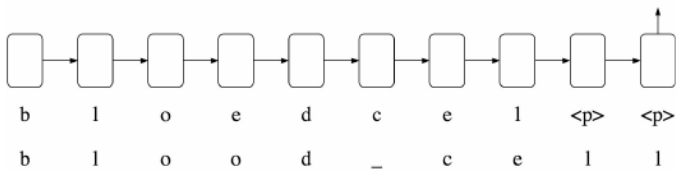
Figure 10. Character-level representation in an LSTM